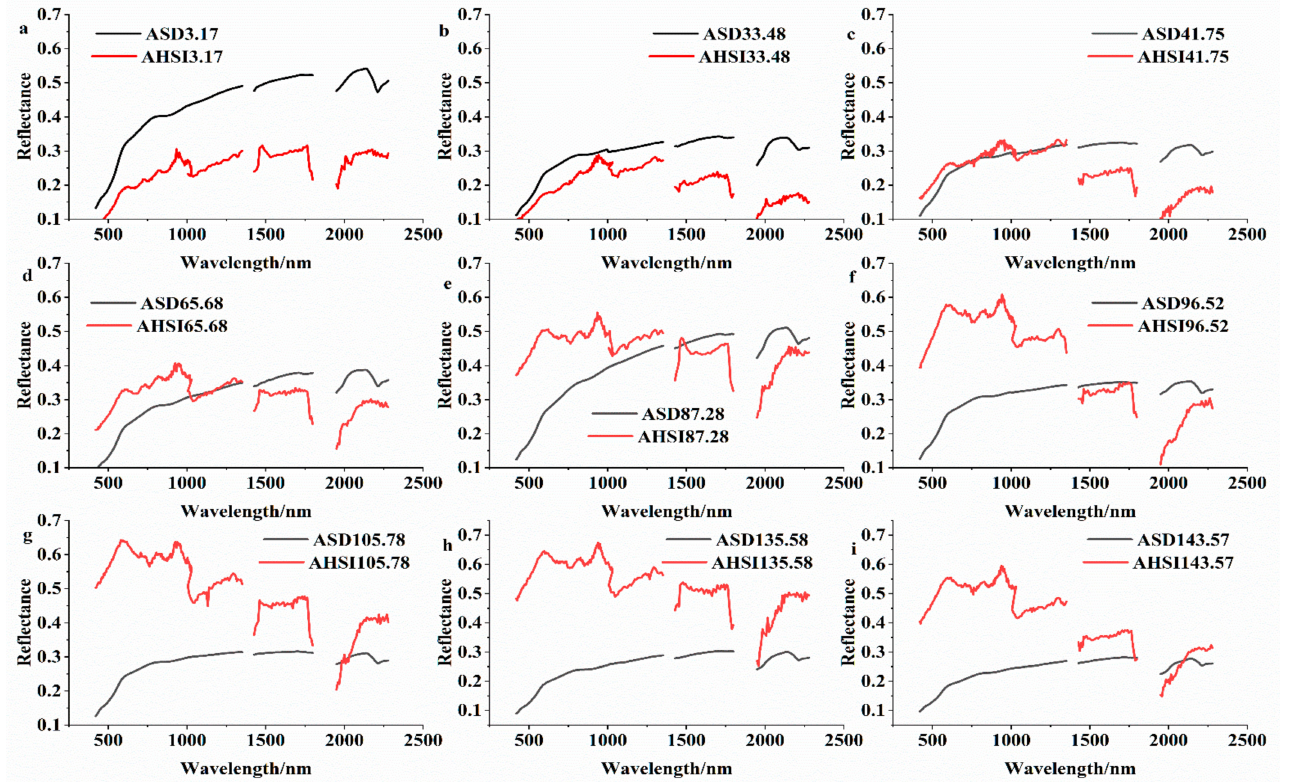
Figure 4. Resampling of the spectral curves obtained by laboratory instruments (ASD) to spectral curves obtained by satellite sensors (AHSI) and comparison with the AHSI data. ( a – i ) shows the comparison between ASD data and AHSI data under soil salt content of 3.17 g/kg, 33.48 g/kg, 41.75 g/kg, 65.68 g/kg, 87.28 g/kg, 96.52 g/kg, 105.78 g/kg, 135.58 g/kg and 143.57